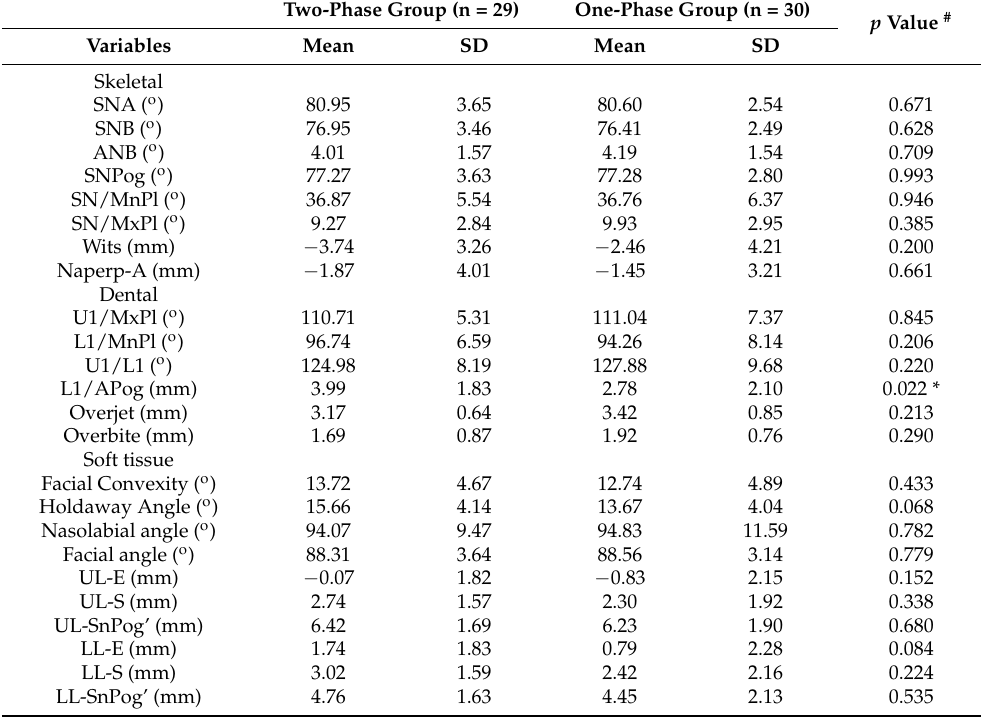
Table 5. Intergroup comparison of post-treatment